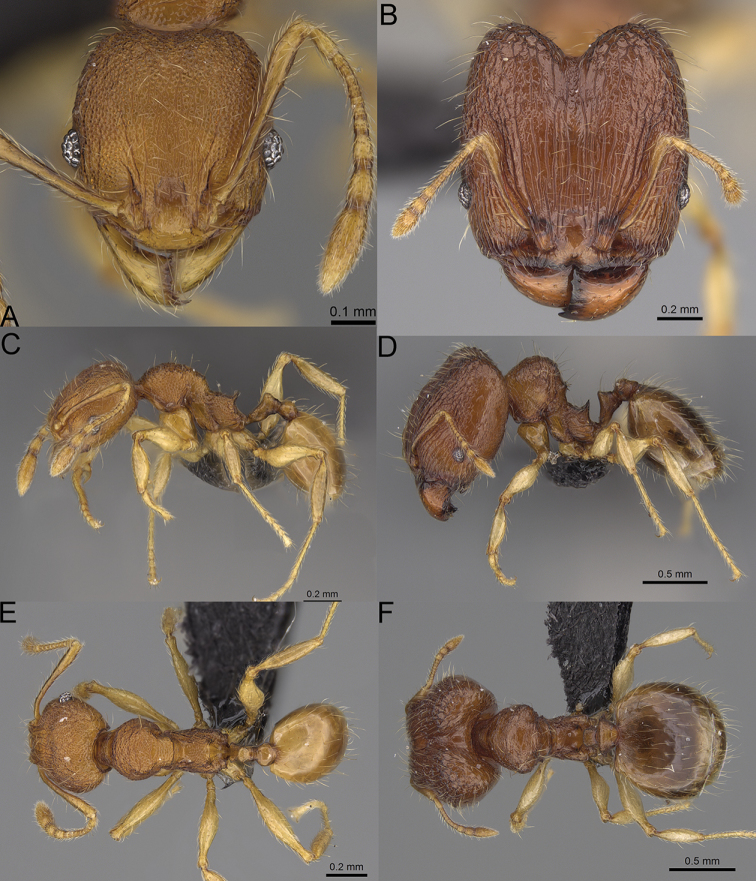
Pheidole
longipilosa sp. nov., full-face view (A), profile (C), and dorsal view (E) of paratype minor worker (CASENT0235043) and full-face view (B), profile (D), and dorsal view (F) of holotype major worker (CASENT0498298).